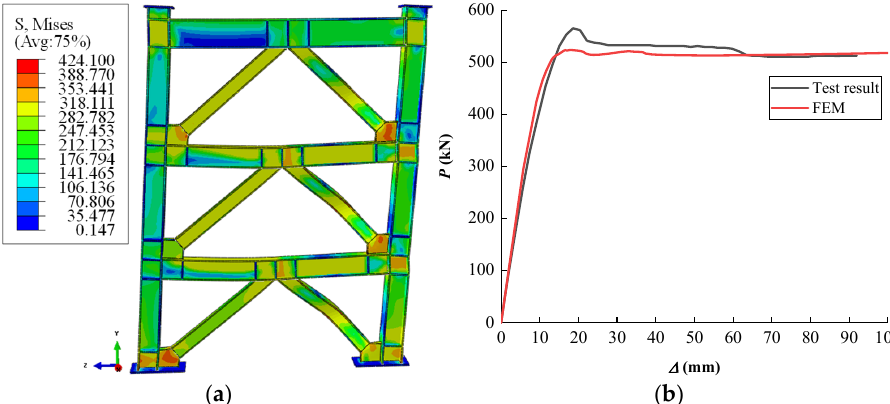
Figure 7. Validation result of finite element modeling. ( a ) deformation of a three ‐ story concentrically ‐ braced steel frame; ( b ) load ‐ displacement curves from experiment and the FE analysis.